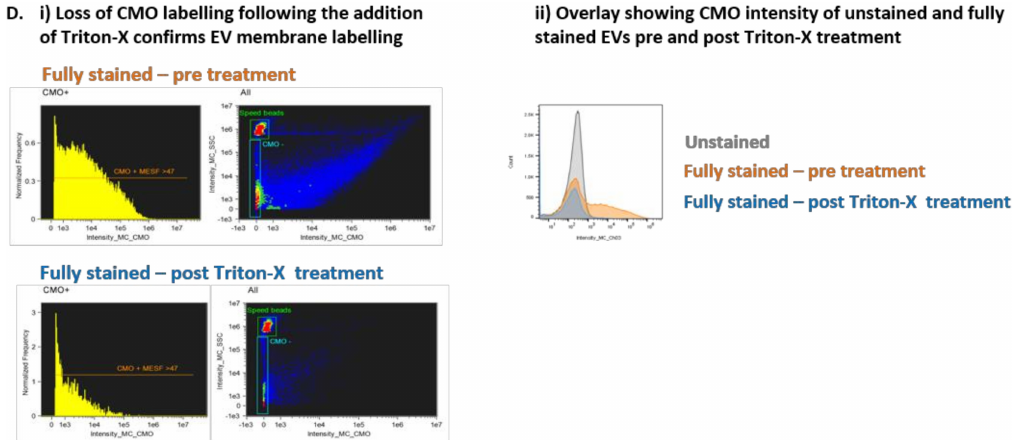
Figure 2. Cell Mask Orange can label EVs to enable standardisation across experiments. ( A ) Cell Mask Orange (CMO) labelling was optimised by titration using parent cells. Serial dilutions from 1 in 1000–100,000 were used to label parent UW228-2 cells and analysed by flow cytometry. A clear relationship between CMO concentration and fluorescence intensity is shown. ( B ) ISX: Objects / mL reduce with increased sample dilution (i) whilst CMO intensity remains constant (ii).